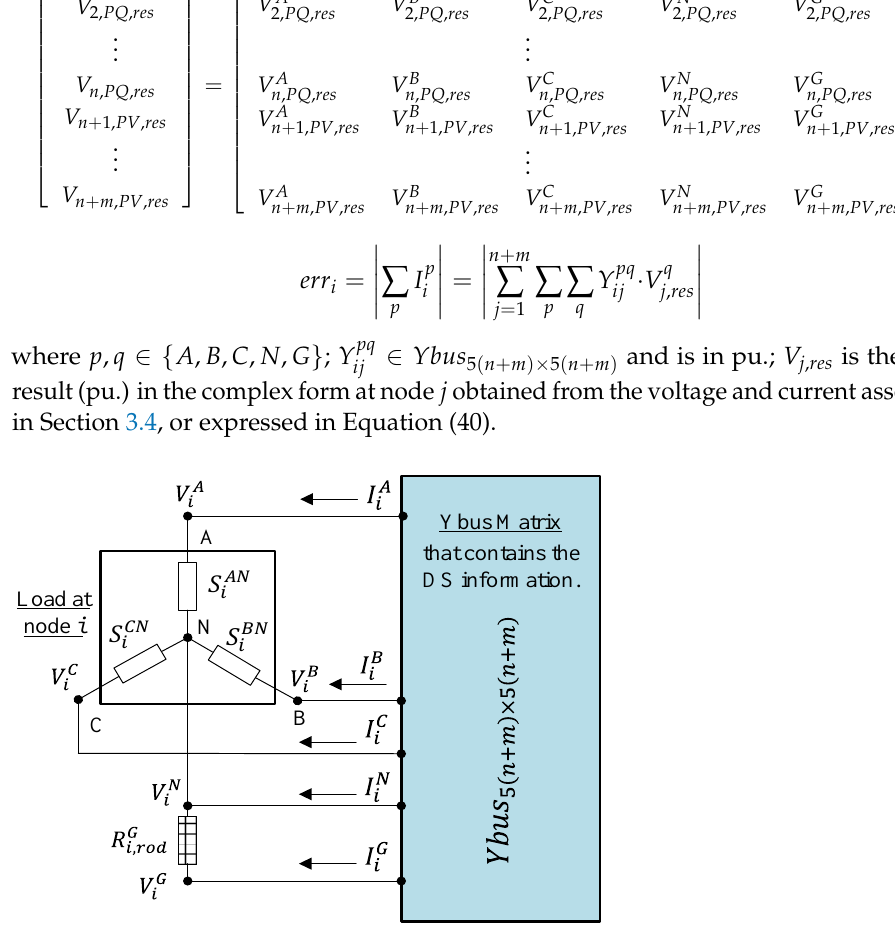
Figure 7. Node i in Ybus matrix that is separated into phase-A, -B, -C, -N, and